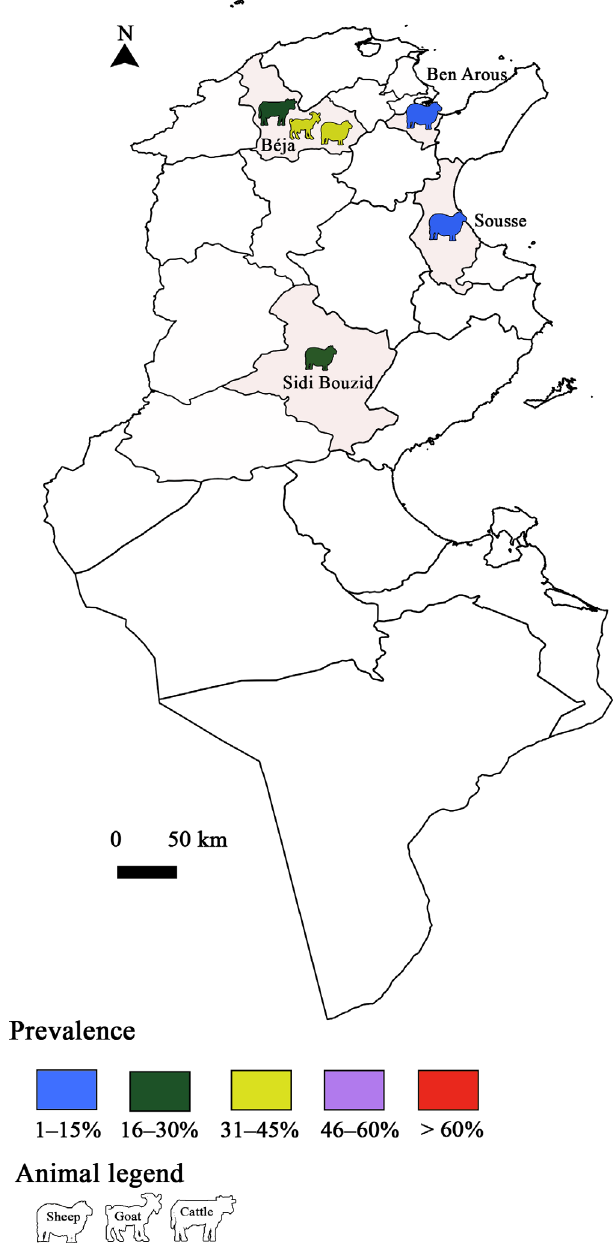
Figure 3. Prevalence of Toxoplasma gondii infection in Tunisia: Animal toxoplasmosis, seroprevalence.